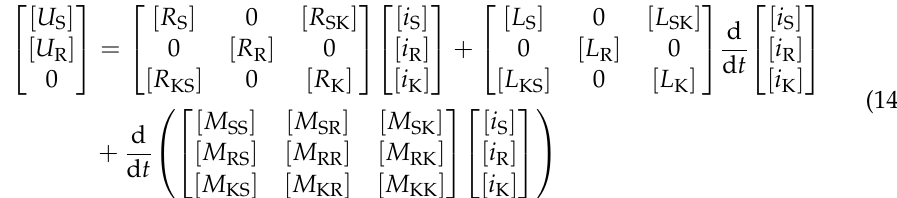
tance L S , and resistance R S are adjusted according to the changed winding